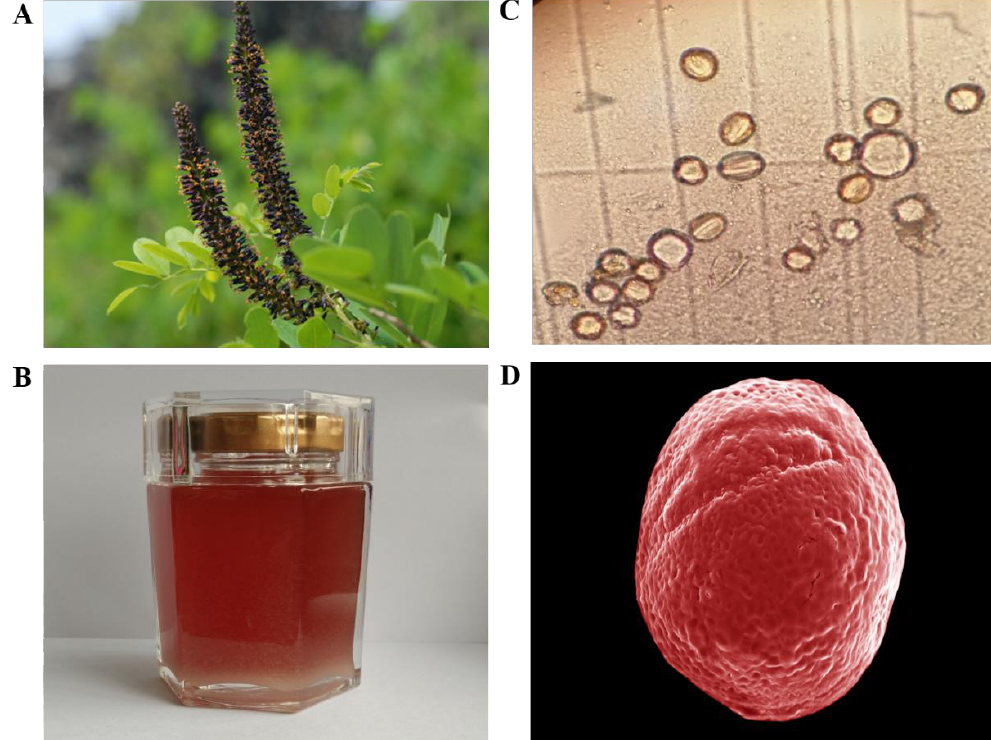
Figure 1. Flower, honey, and pollen of Amorpha fruticosa L . ( A ) Flower of Amorpha fruticosa L., ( B ) Amorpha fruticosa L . honey (AFH). ( C ) Microscope photomicrographs (×40) of pollen in AFH. ( D ) Scanning electron micrographs (SEM) of pollen in AFH. SEM experimental conditions: EHT: 5.00 KV. WD: 6.7 mm, Mag: 4.28KX, Signal A: Inlens.